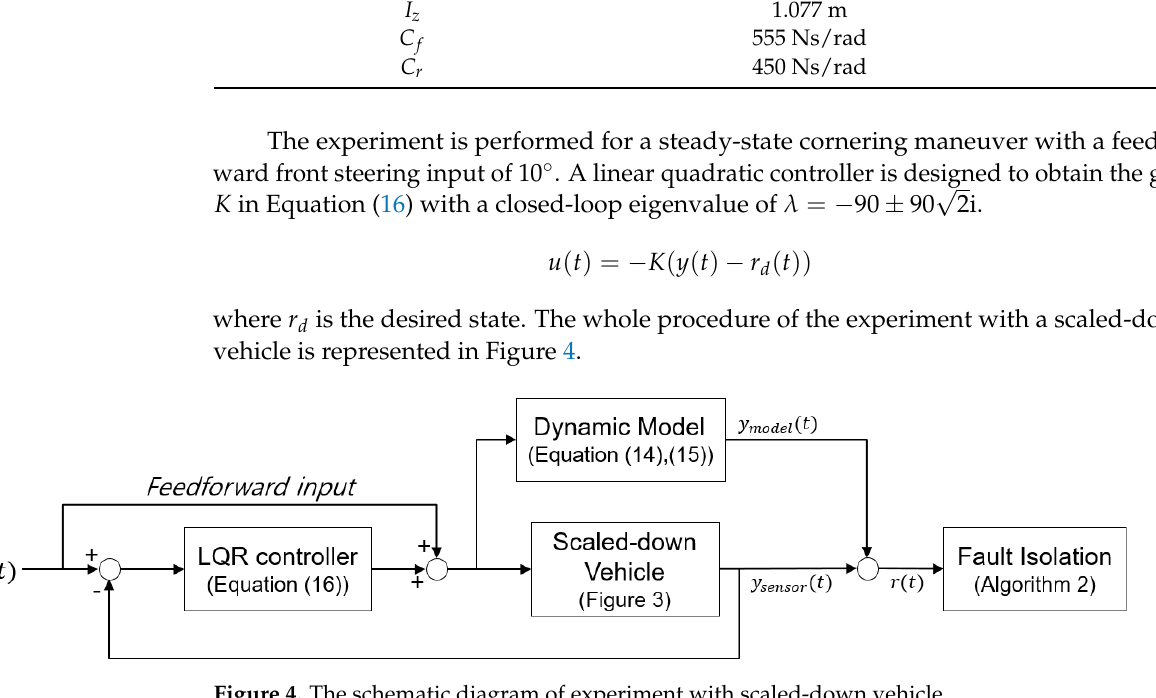
Figure 4. The schematic diagram of experiment with scaled-down